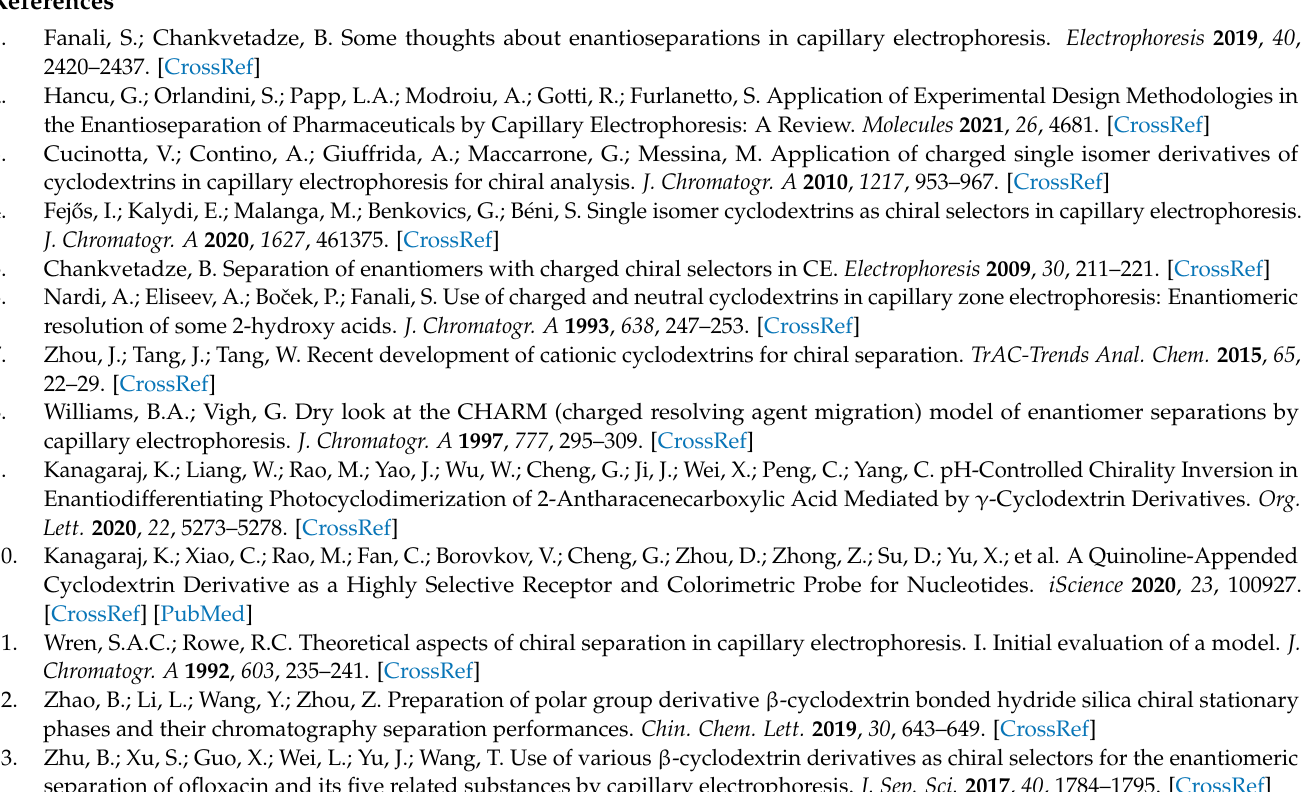
2D ROESY spectrum of D,L-Dns-Val/PIP- β -CD, Figure S64. Stacked 1H NMR spectra of D,L-Dns- Val/MO- β -CD system in 20 mM NaH2PO4 buffer at pH* 6.0 with increasing MO- β -CD concentration, Figure S65. Stacked partial 1H NMR spectra of D,L-Dns-Val/MO- β -CD system in 20 mM NaH2PO4 buffer at pH* 6.0 with increasing MO- β -CD concentration, Figure S66. 2D ROESY spectrum of D,L-Dns-Val/MO- β -CD system, with intermolecular correlations emphasized and structure of the compounds, Figure S67. Stacked 1H NMR spectra of D,L-Dns-Val/PIPA- β -CD system in 20 mM NaH2PO4 buffer at pH* 6.0 with increasing PIPA- β -CD concentration, Figure S68. Stacked partial 1H NMR spectra of D,L-Dns-Val/PIPA- β -CD system in 20 mM NaH2PO4 buffer at pH* 6.0 with increasing PIPA- β -CD concentration, Figure S69. 2D ROESY spectrum of D,L-Dns-Val/PIPA- β -CD system, with intermolecular correlations emphasized and structure of the compounds, Figure S70. Stacked series of 1H NMR spectra of Dns-Val/MO- β -CD system with increasing molar fraction of MO- β -CD from top to bottom, Figure S71. Chemical shift changes of the aromatic protons of Dns-Val upon changing the mole fraction of Dns-Val in the presence of MO- β -CD, Figure S72. Job’s plot derived from the chemical shift changes of H6 proton of Dns-Val in presence of MO- β -CD. Author Contributions: Conceptualization, M.M. and S.B.; methodology, I.F.; formal analysis, I.F. and E.K.; investigation, I.F., E.K., E.L.K. and M.S.; writing—original draft preparation, I.F. and